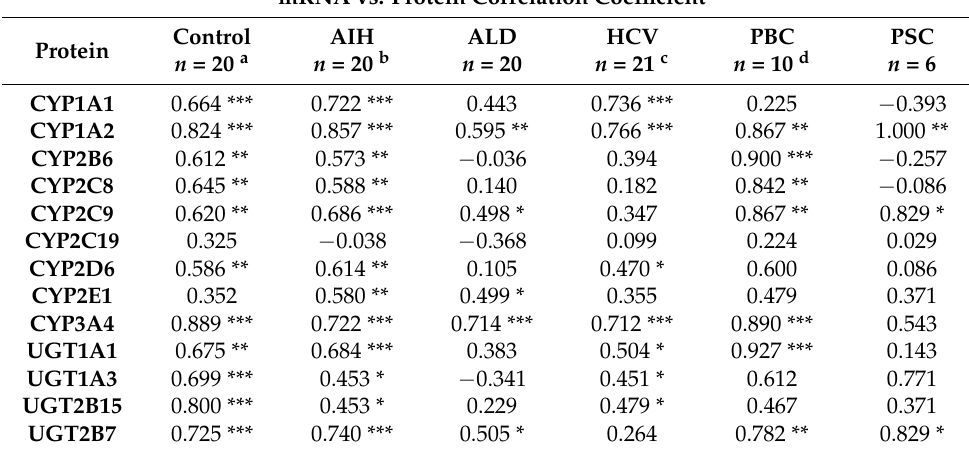
Table 1. Correlation (Spearman coefficient, r) between protein and mRNA levels of the P450s and UGTs in human livers stratified by the liver pathology. mRNA vs. Protein Correlation Coefficient Control Protein n = 20 a